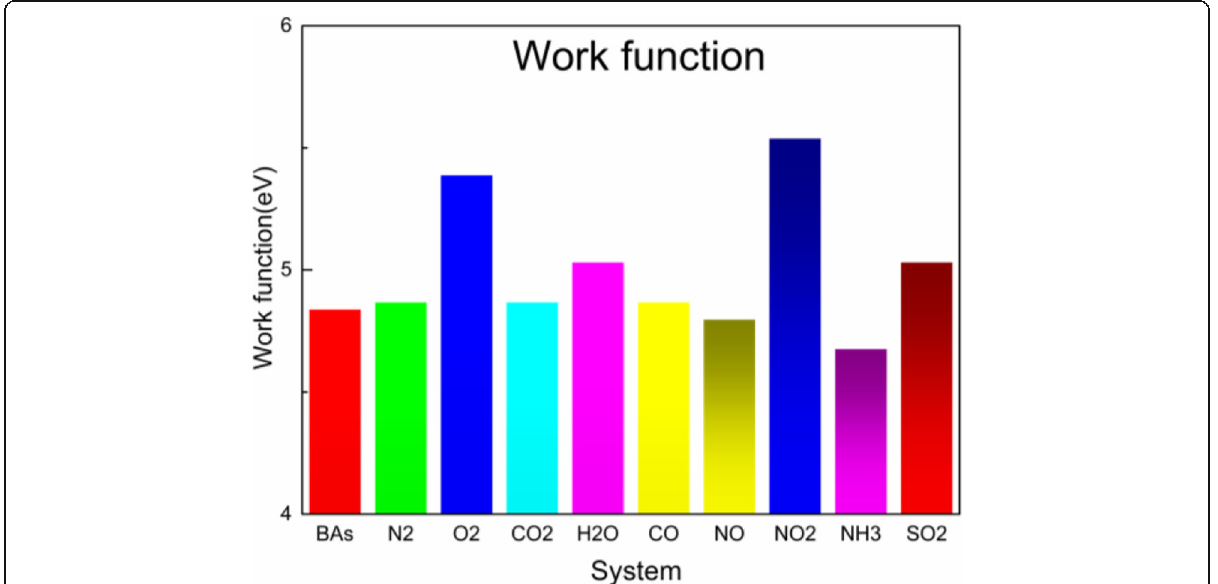
Fig. 5 Work function of BAs N 2 /BAs, O 2 /BAs, CO 2 /BAs, H 2 O/BAs, CO/BAs, NO/BAs, NO 2 /BAs, NH 3 /BAs, and SO 2